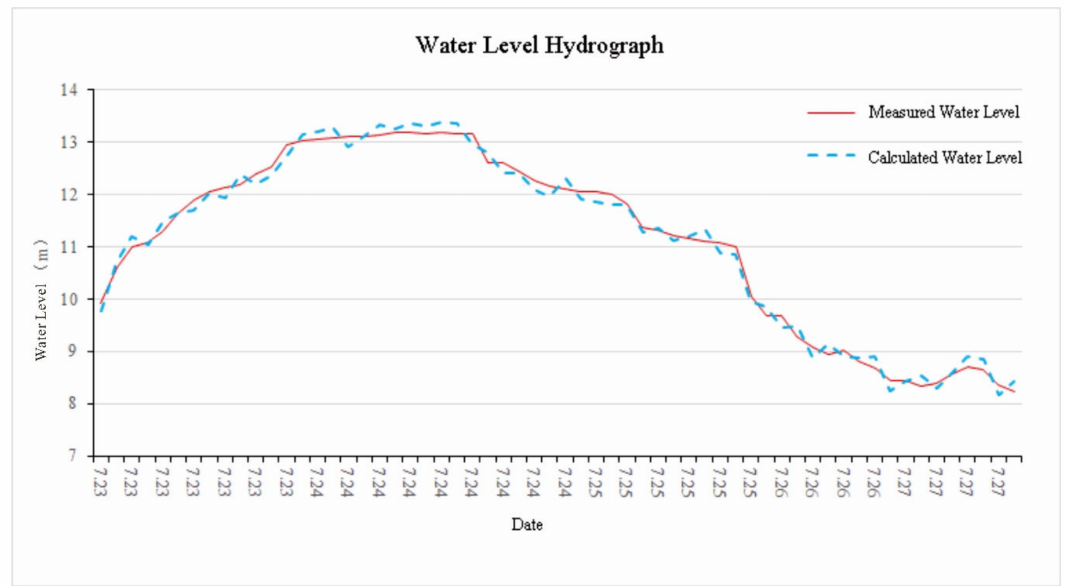
Figure 4. Water level comparison of model calculation results and measured data under the typhoon “Chanthu” flood in 2010. Table 2. Comparison between the measured and calculated results of typhoon “Chanthu” flood in 2010. Serial